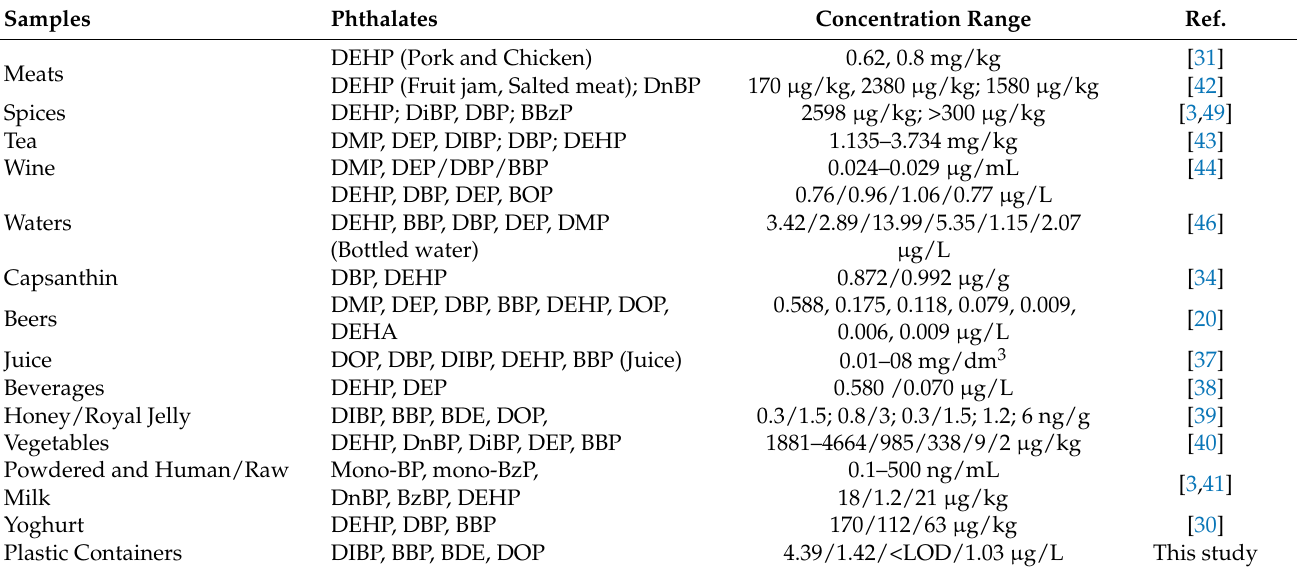
Table 5. Levels of different phthalates found in different types of samples reported in the